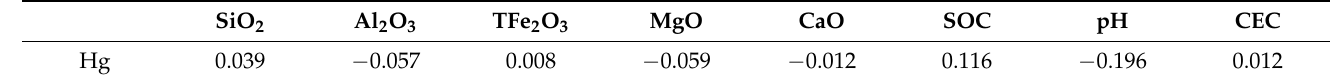
Table 9. The correlation coefficient between some major compounds and Hg (N =